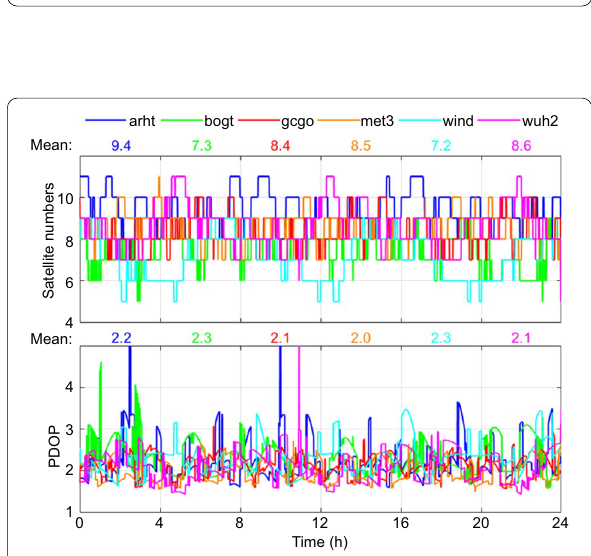
Fig. 9 Observed BDS-3 satellite numbers and corresponding PDOP values of different stations (DOY 283/2021)